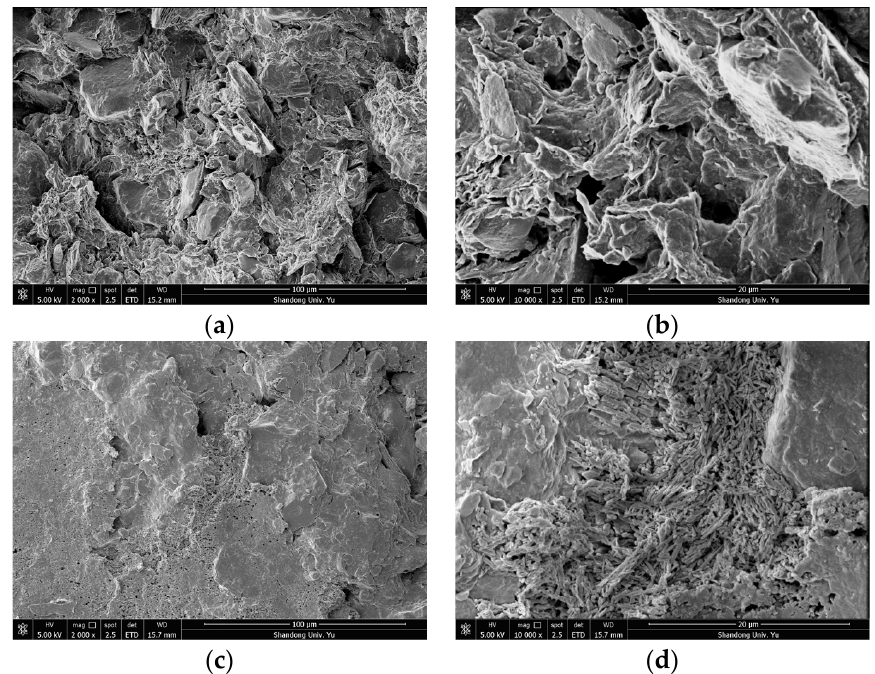
Figure 4. SEM images of the representative microstructure of the DK-44-45 group. ( a ) 2000 times, in the vertical direction; ( b ) 10,000 times, in the vertical direction; ( c ) 2000 times, in the horizontal direction; ( d ) 10,000 times, in the horizontal direction.